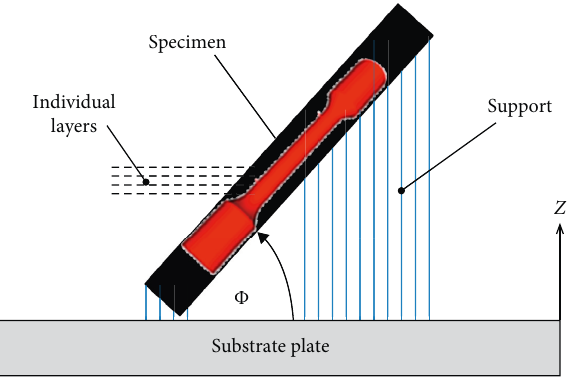
Figure 1: Schematic of sample orientations and description via the polar angle ( Φ ); Φ � 0 ° equals sample orientation parallel to the layers, and Φ � 90 ° is the perpendicular